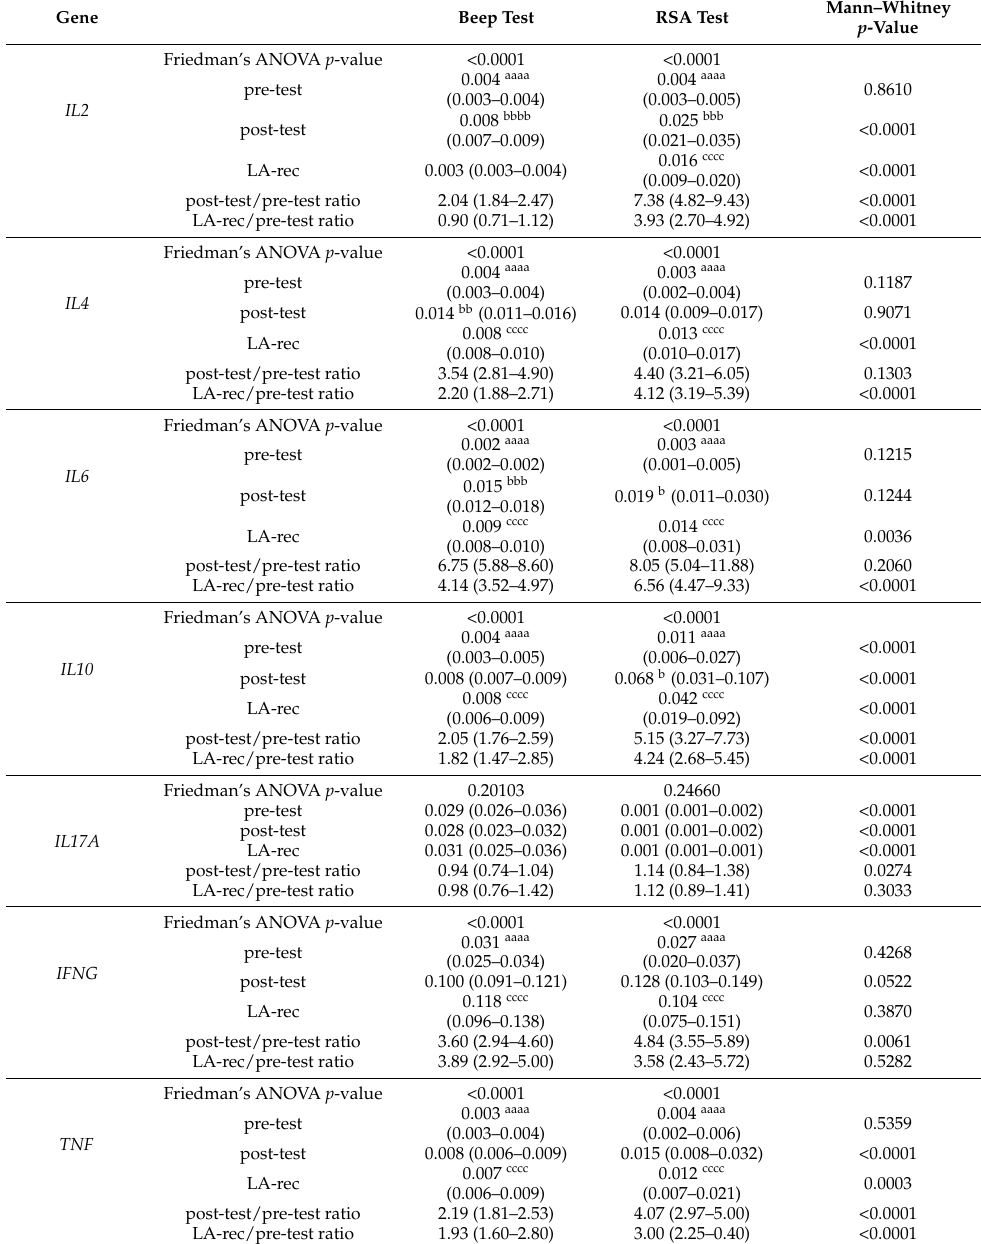
Table 5. The expression (2 − ∆ Ct values) of genes encoding selected cytokines of studied participants’ blood